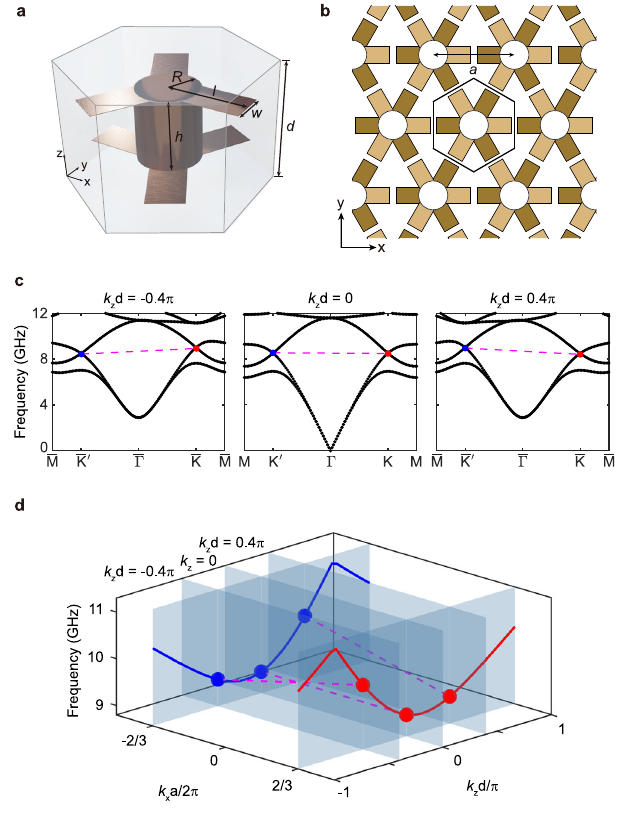
Fig. 2 | Photonic metacrystal possessing ANLs. The unit cell ( a ) and top view ( b ) ofthephotonicmetacrystalwith D 3d pointgroupsymmetry.Structuralparameters: h =4mm, l =4.6mm, w =2mm, R =1.8mm. The in-plane and out-of-plane lattice constants are a =10mm and d =7mm, respectively. c Bulk band structures on different k z planes. For the zero k z , two Dirac points locate at the same frequency, resulting in a fl at edge band (dashed magenta line); for nonzero k z , the two